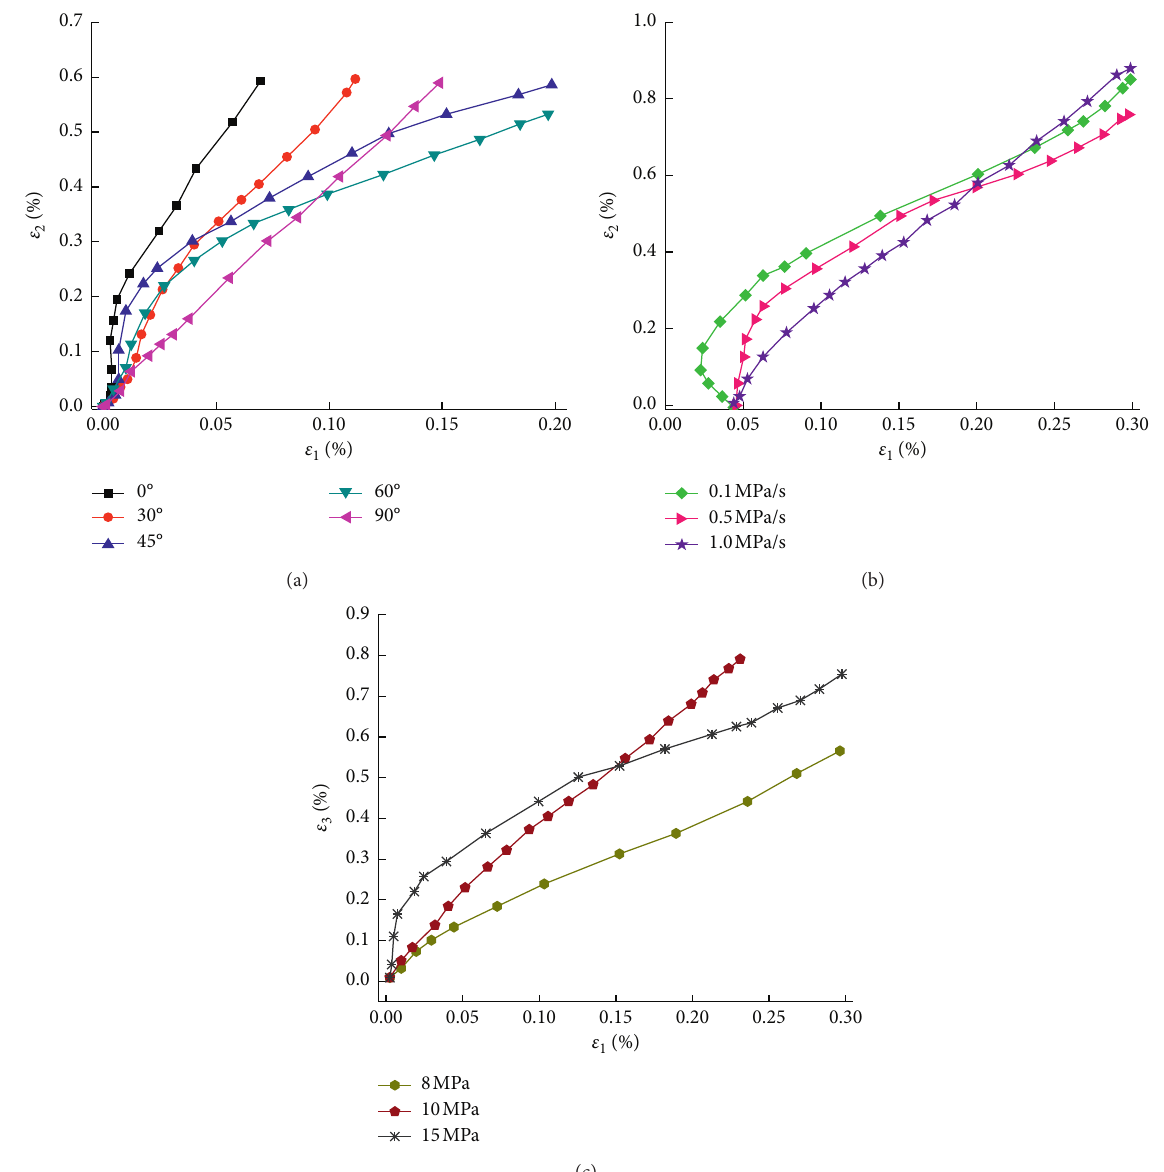
Figure 4: ε − ε curves of cracked specimens under axial unloading and radial unloading conditions. (a) Effect of crack angle. (b) Effect of 3 1 unloading rate of confining pressure. (c) Effect of initial confining